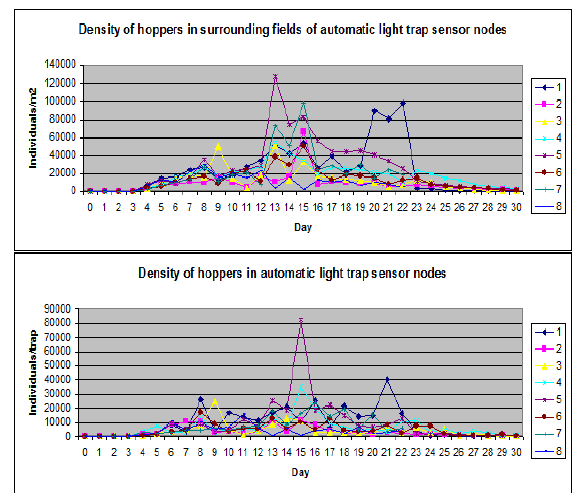
Figure 22. Rice field andautomaticlight trap sensornodedata collectionafter 30 days of